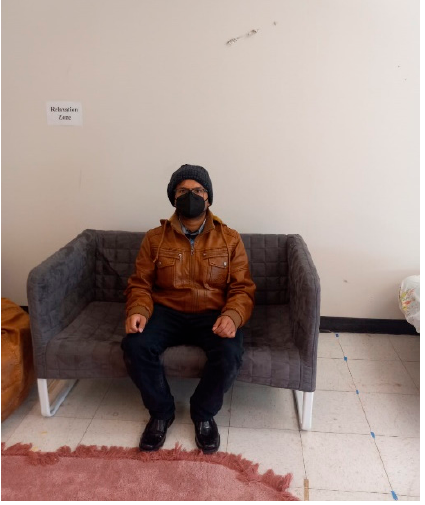
Figure 9. A participant sitting on a couch in the relaxation zone.